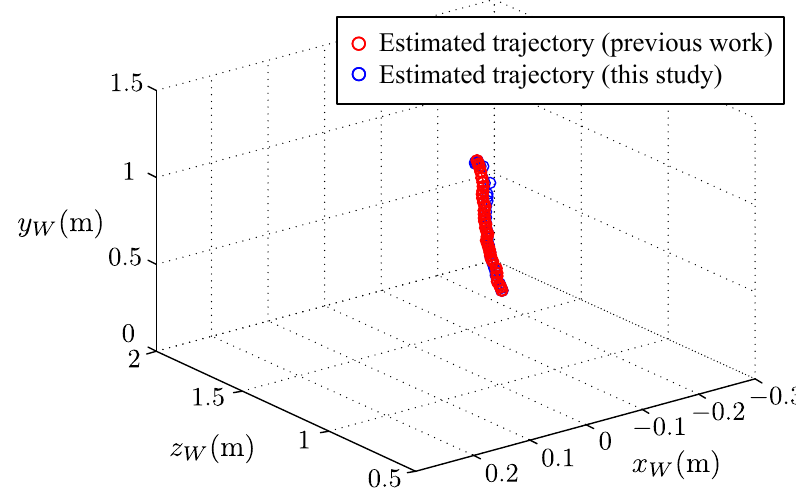
Figure 17. A free falling ball: estimated trajectory of the ball.